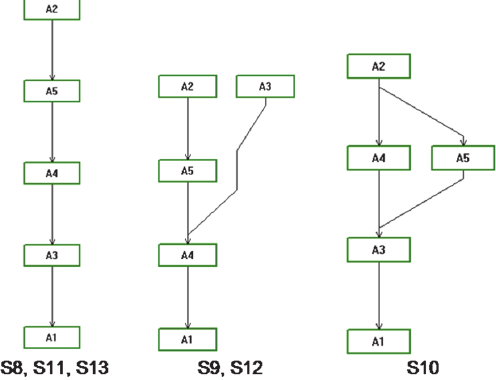
Fig. 7. Scenarios for variation of